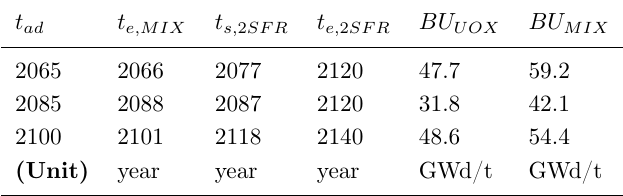
Table 3. Parameters of optimal adaptive strategies minimizing t e, 2 SFR for three t ad in SCN MIX2SFR